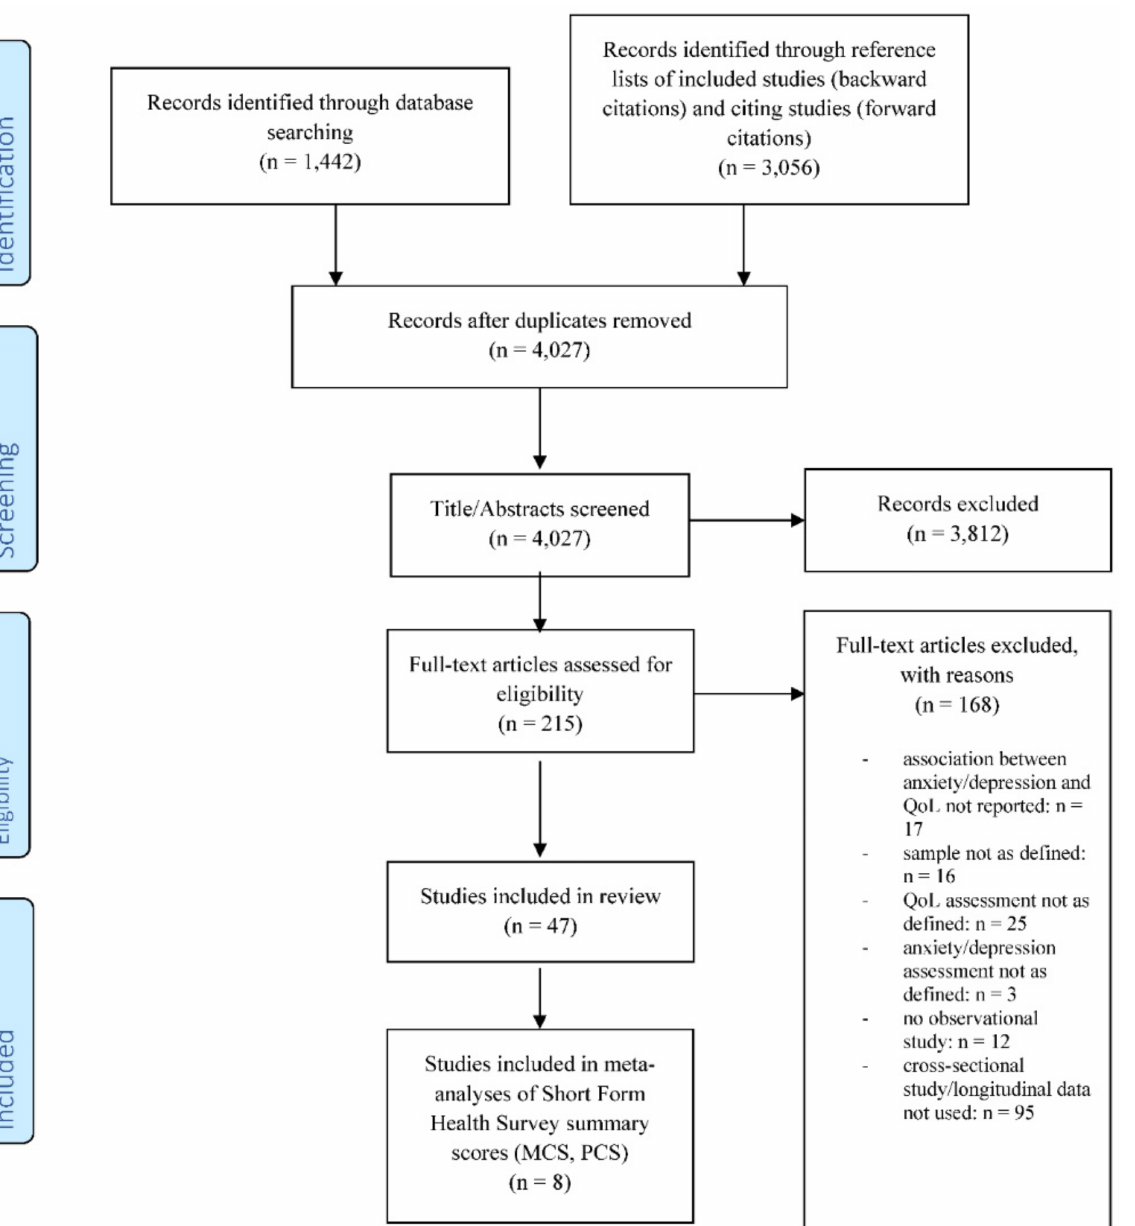
Figure 1. Study flow (PRISMA flow